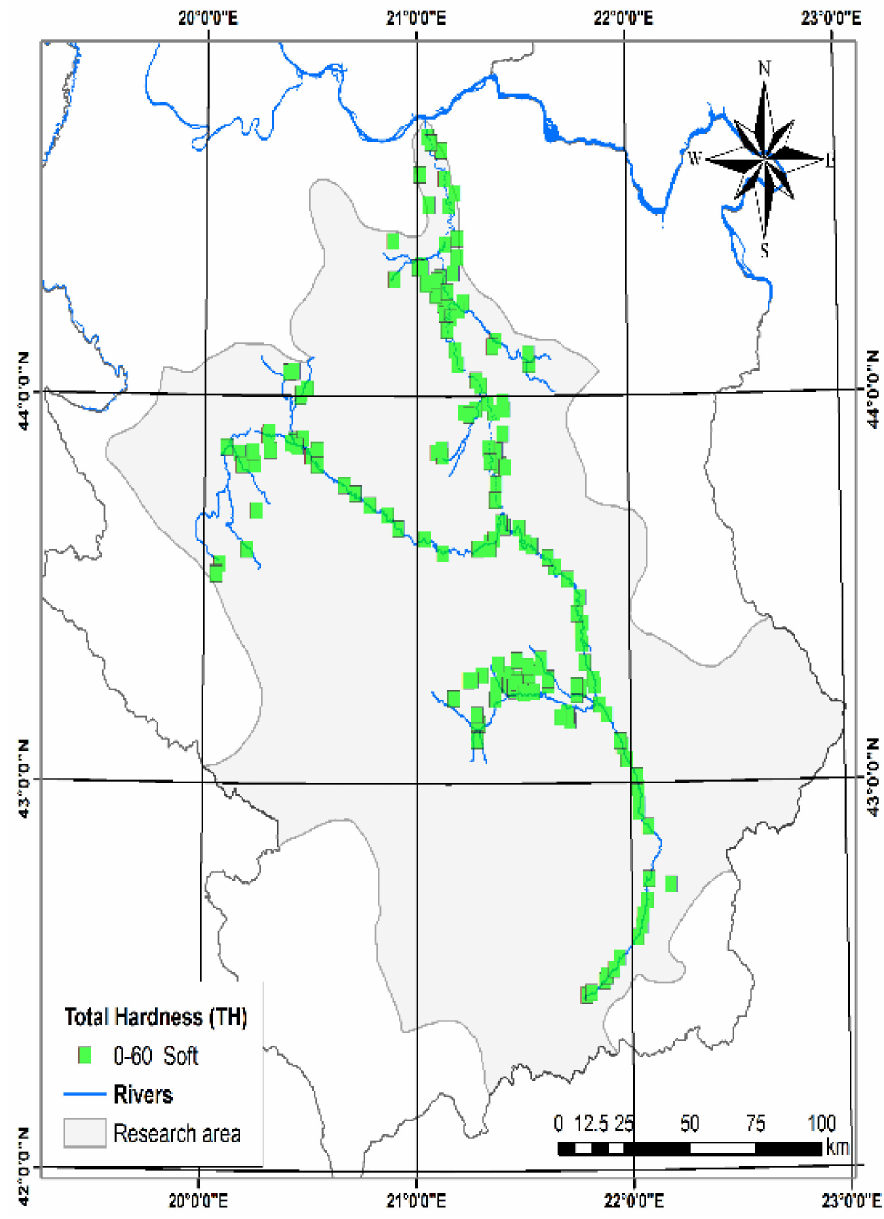
Figure 6. Spatial distribution maps of